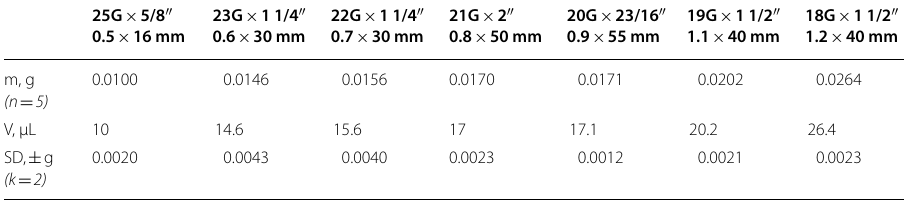
Table 1 Water drop size as a function of needle diameter. Water density assumed as 1 g mL −